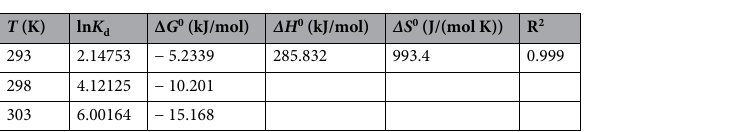
Table 4. Adsorption thermodynamic parameters of the adsorption of uranyl ions by ZnNiAl-LDHs.